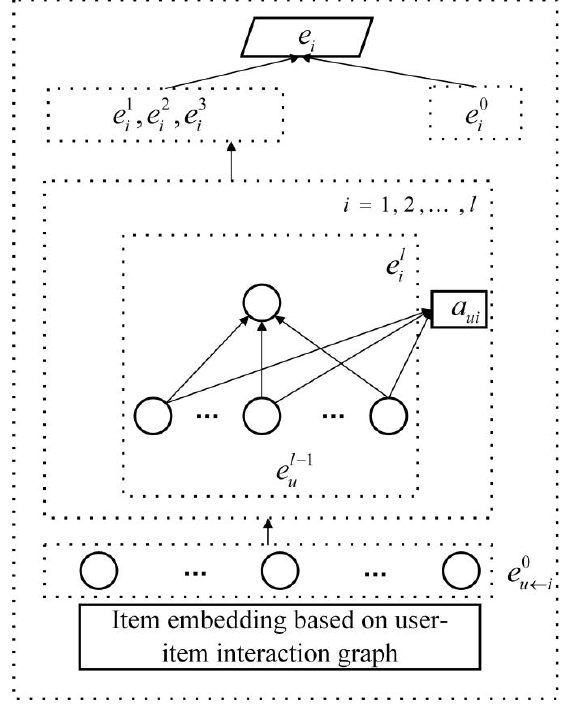
Figure 4. Item embedding model based on the user-item interaction graph.